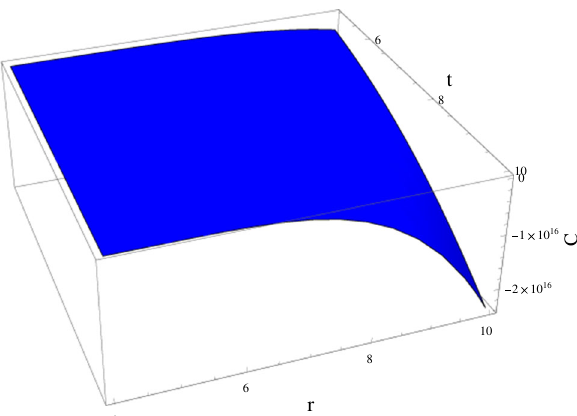
Fig. 3 Plots of C versus t and r for κ = 0 . 5 and m = 1 . 4, indicat- ing that f ( R ) terms effects the close universe instead of expanding to maximum size and then collapsing, it expands